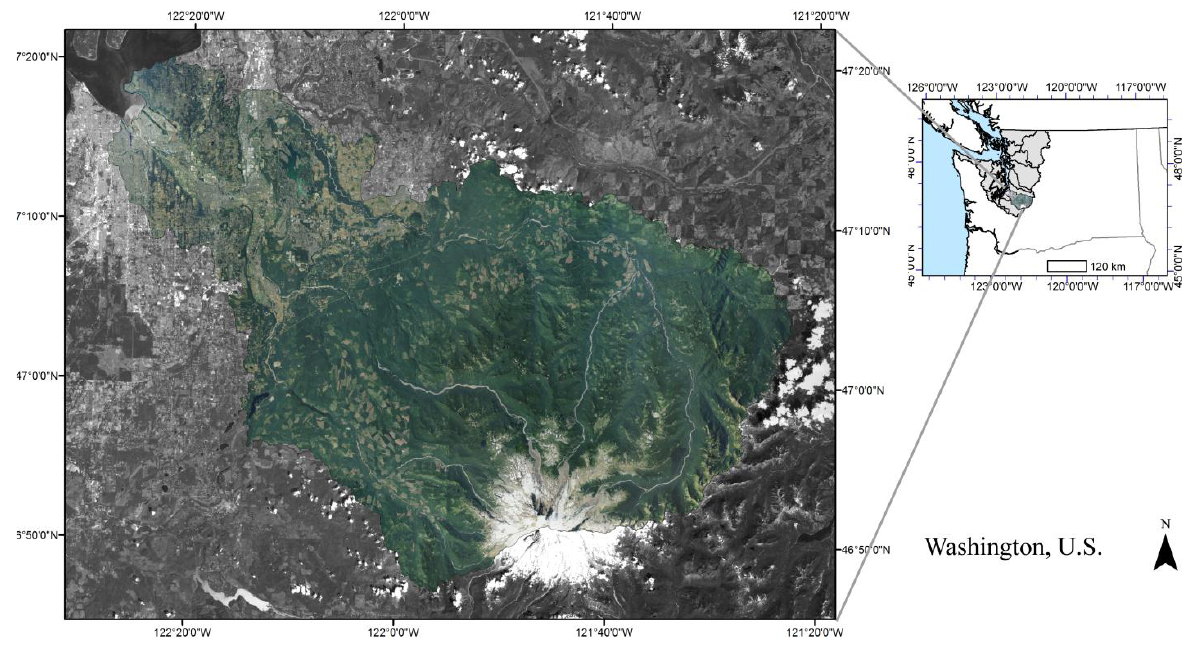
Figure 2. The Puyallup watershed is one of 19 watersheds making up the Puget Sound region of Washington State. The watershed covers 272,932 ha and rises from the city of Tacoma at sea level up to the top of Mt. Rainier at 4394